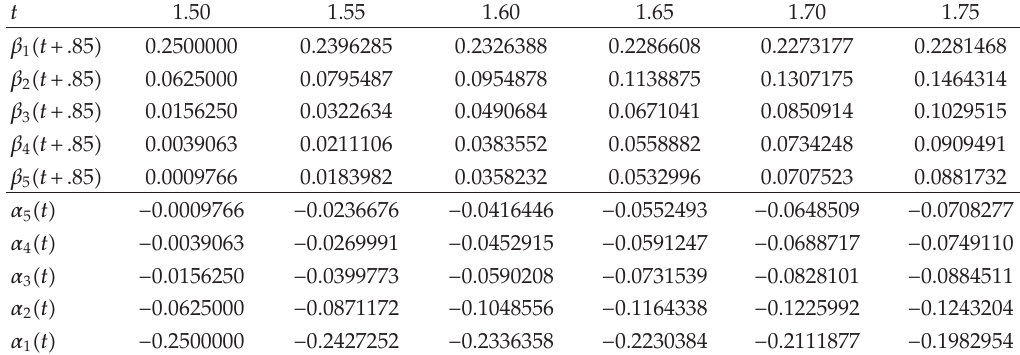
Table 1: Values of the successive lower/upper approximations α k (cid:3) t (cid:6) and β k (cid:3) t (cid:7) . 85 (cid:6)